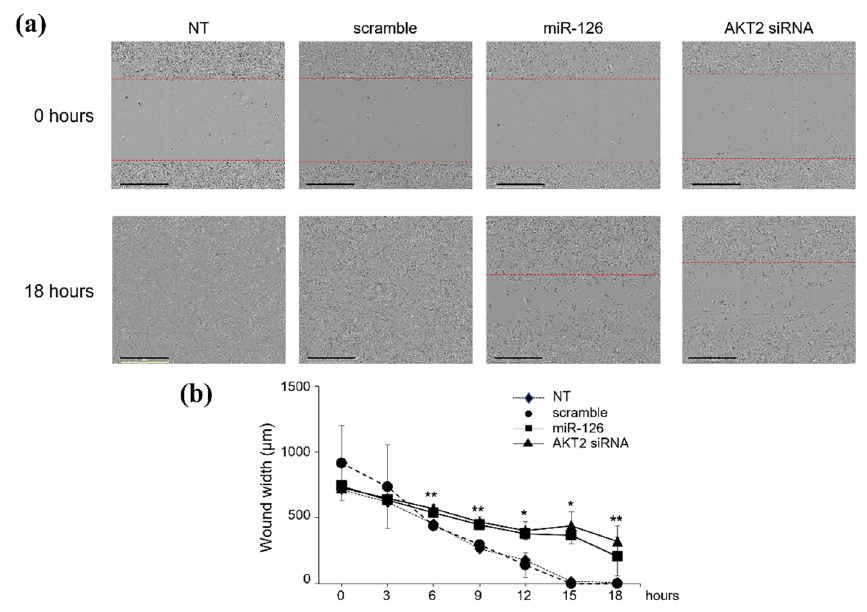
Figure 2. miR-126-3p/AKT2 axis reduces migration of BT549 cells. ( a ) Scratch wound assay per- formed on BT549 cells left untreated (NT) or transiently transfected with either scramble oligo (scramble) or miR-126-3p-mimic (miR-126) or AKT2 siRNA. Migration was monitored for up to 18 h. The leading edge of the wound is highlighted red. ( b ) Graphical view showing the wound width (µm), in relation to incubation times. Results are representative of three independent experiments, each performed in quintuplicate and reported as mean ± S.E.M. * p < 0.01 and ** p < 0.05 versus scramble. Scale bars: 400 µM.